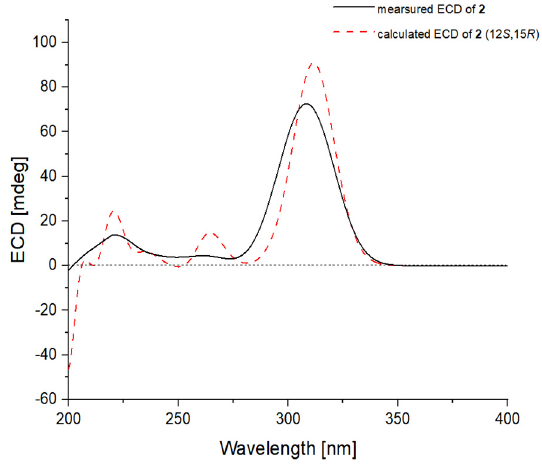
Figure 5. Experimental ECD spectrum of 2 (black line) comparing with that calculated for (12 S ,15 R ) − isomer of 2 at BH&HLYP/TZVP level (red dashed line).